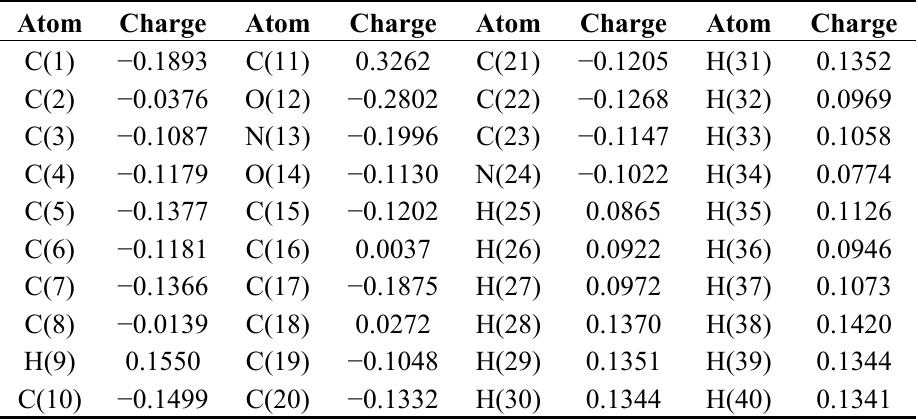
Table 5. Mulliken charge of the DMPO